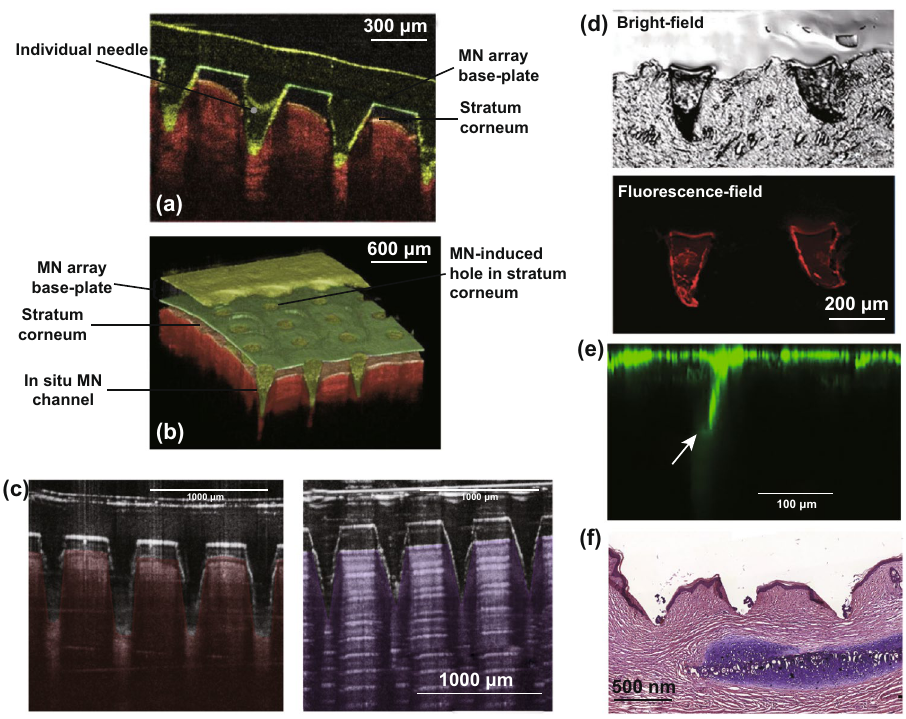
Fig. 9 a Optical coherence tomography (OCT) 2D cross-sectional image from penetration of polymeric MNs arrays with height of 600 µm into human forearm skin. b 3D OCT image created from 2D images by Ability Photopaint®. Reprinted from Ref. [125] with permission from Springer. c Optical coherence tomography images taken from MNs inserted in neonatal pig skin (left panel) and eight layers of Parafilm® M (right panel). Reprinted from Ref. [96] with permission from Elsevier. d Bright-field and fluorescence-field images of arrowheads inserted into mouse skin. Reprinted from Ref. [126] with permission from Royal Society of Chemistry. e Visualization of the transport of 200-nm FITC- nanoparticles into human skin (up to 250 μm) after using confocal microscopy. The conduit is indicated by an arrow. Reprinted from Ref. [121] with permission from Elsevier. f Images of hematoxylin and eosin (H&E)-stained section of hypertrophic scar tissue (7 µm) after the application of MNs. Reprinted from Ref. [85] with permission from